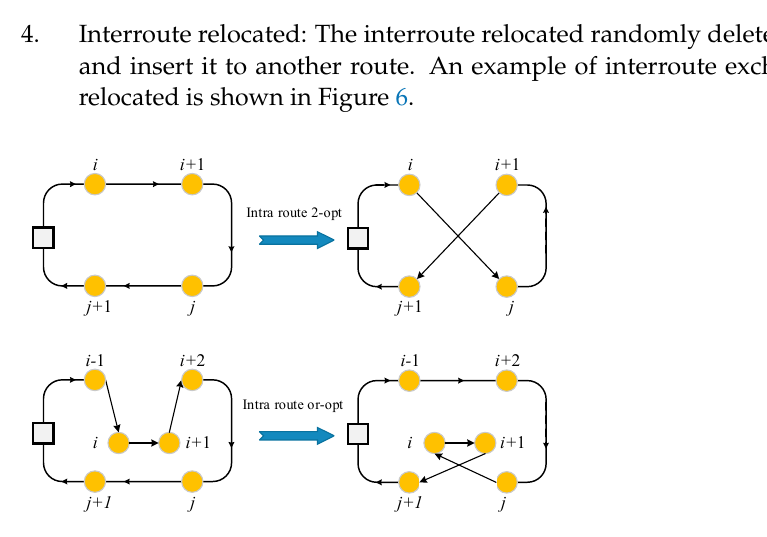
Figure 5. An example of intraroute 2-opt and intraroute or-opt.